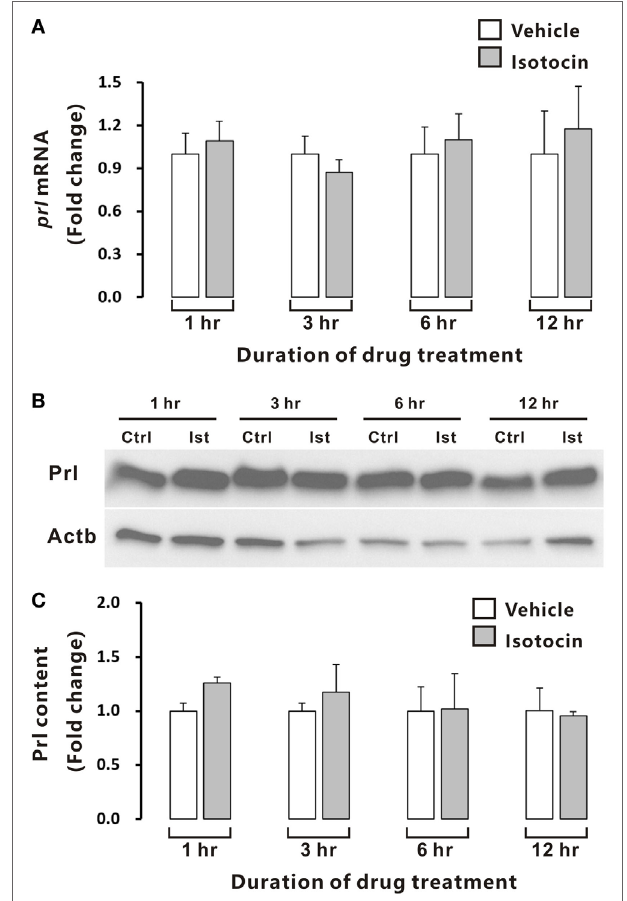
FigUre 9 | Effects of isotocin (Ist) (100 nM) on prl gene expression and prolactin (Prl) contents in ricefield eel pituitary cells. The primary cultured pituitary cells were pre-incubated for 12 h before treating with Ist (100 nM) for 1, 3, 6, and 12 h. prl mRNA levels (a) were analyzed by real-time PCR, and Prl contents were examined with Western blot analysis (B) and further quantified (c) with Gel-Pro analyzer software by applying the integrate optical density, and normalized by those of Actb. Data were expressed as fold change relative to the corresponding control. Bars represent mean ± SEM of pooled results from three separate experiments ( n = 3). Ctrl, vehicle control.